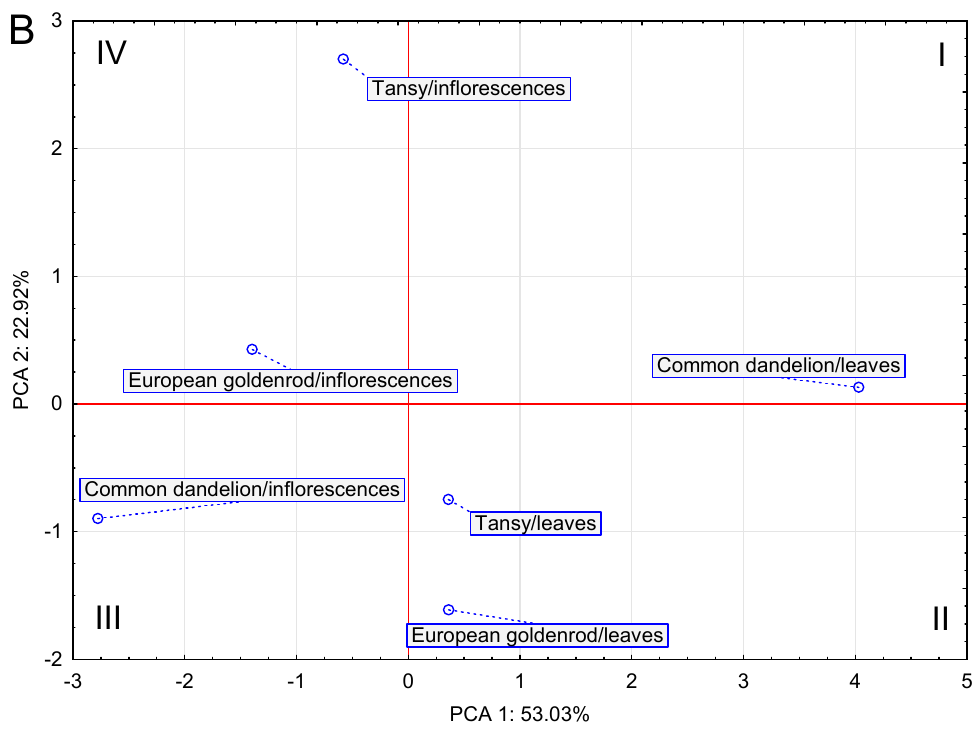
Figure 2. Biplot based on first two principal component axes for proximate composition and antioxidant activity of raw material from Asteraceae family plants ( A ) and distribution of raw material (leaves, inflorescences) based on the first two components obtained from principal component analysis ( B ).